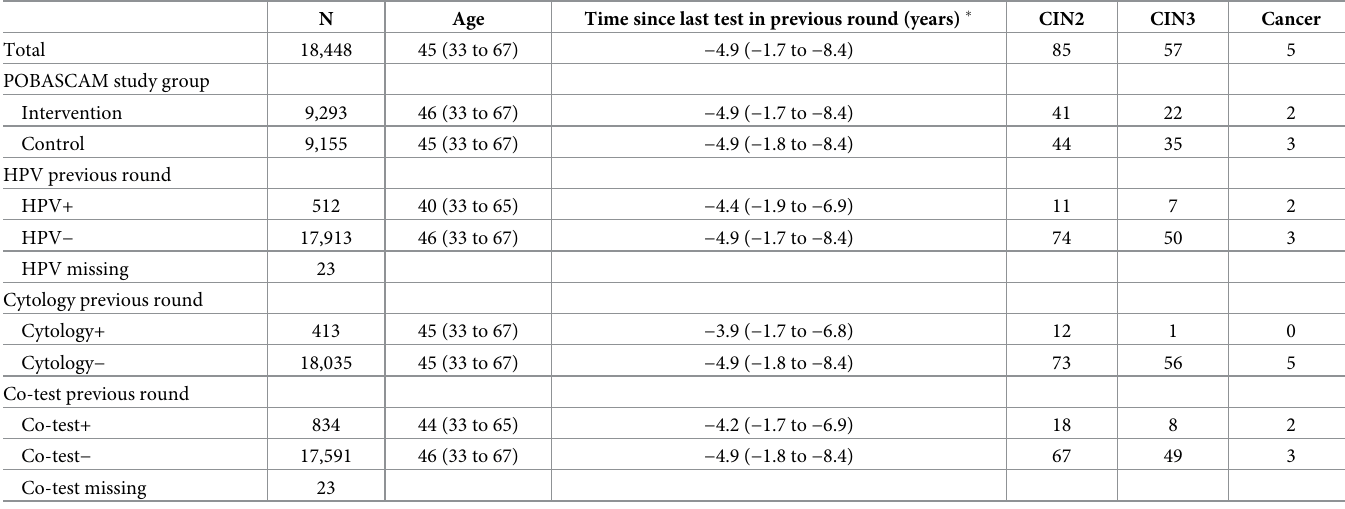
Table 1. Characteristics of the study